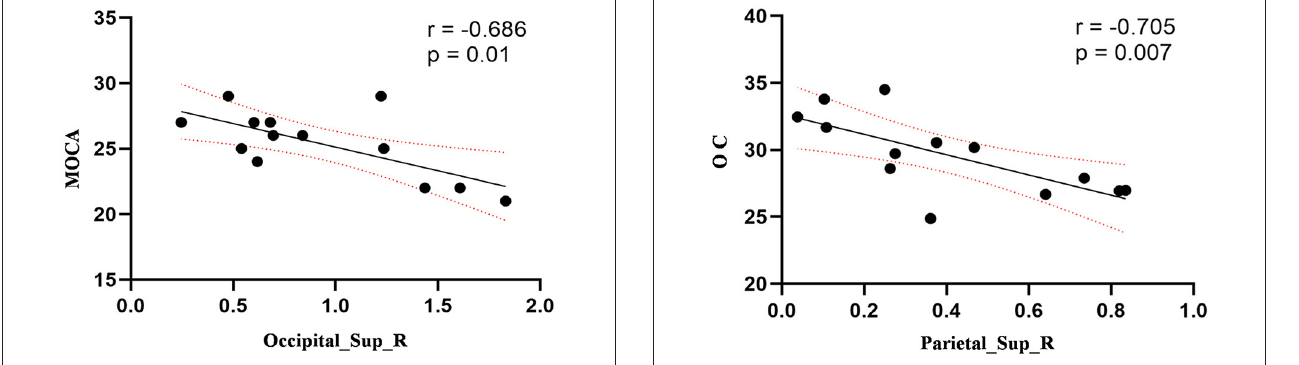
FIGURE 4 | Correlation between ReHo values of the right SOG and the MOCA scores. The ReHo values of right SOG showed a negnative correlation with MOCA scores ( r = − 0.686; P = 0.01).